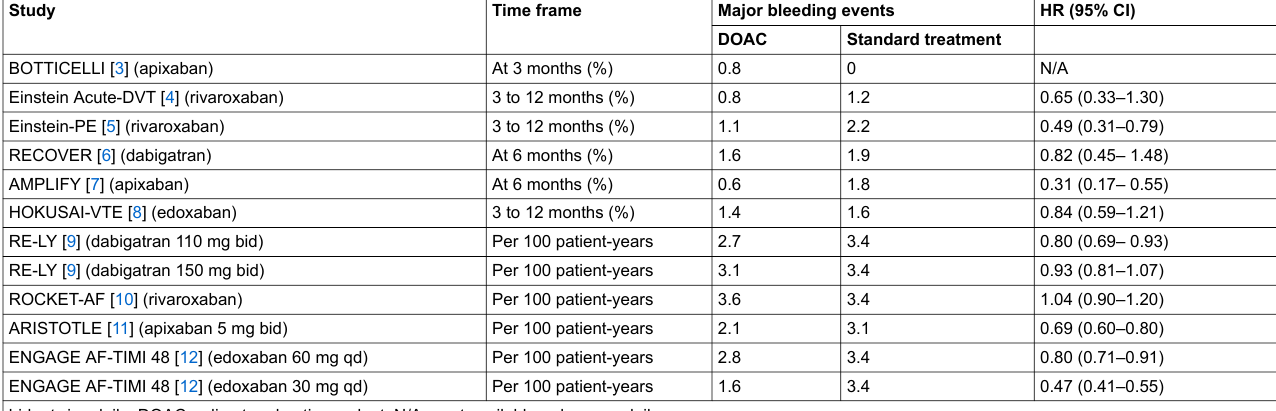
Table 1: Major bleeding events in the clinical trials evaluating the direct oral anticoagulants in the treatment of venous thromboembolism and stroke prevention in atrial